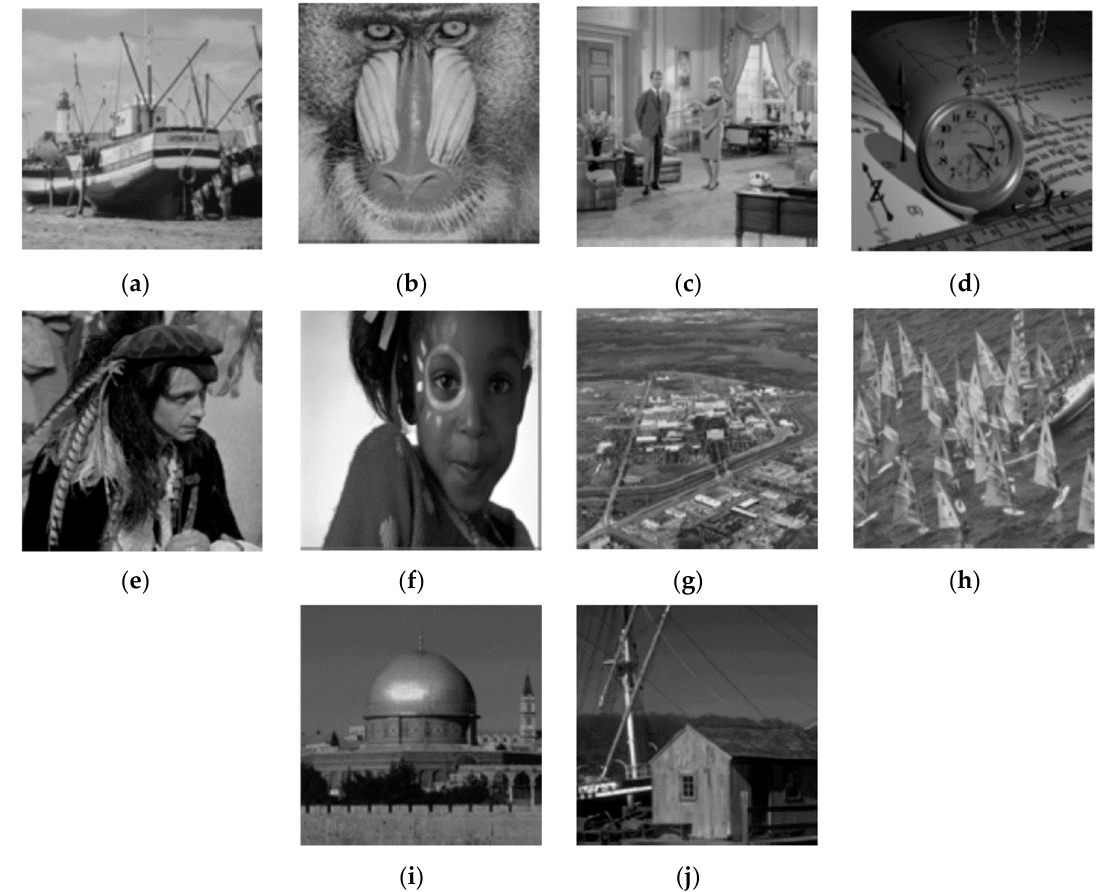
Figure 6. The original tested images used for image upscaling; ( a ) fishing boat; ( b ) baboon; ( c ) couple;